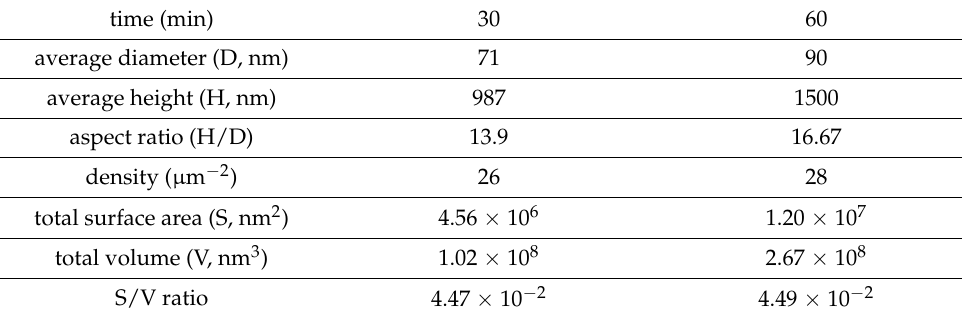
Table 2. Relative results of ZnO NFAs as a function of synthesis time.